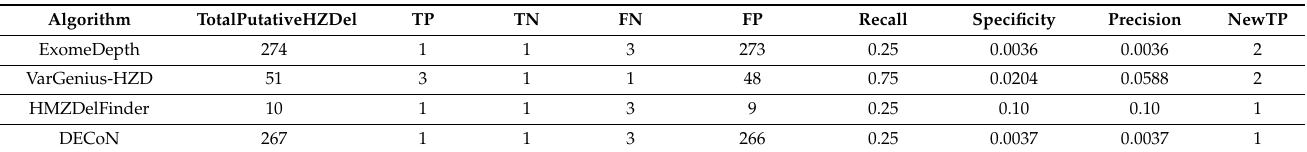
Table 1. Precision/Recall/Specificity obtained by the tools with the 50 samples from 1KGP dataset. TP (True positives), TN (True Negatives), FN (False Negatives), FP (False Positives).